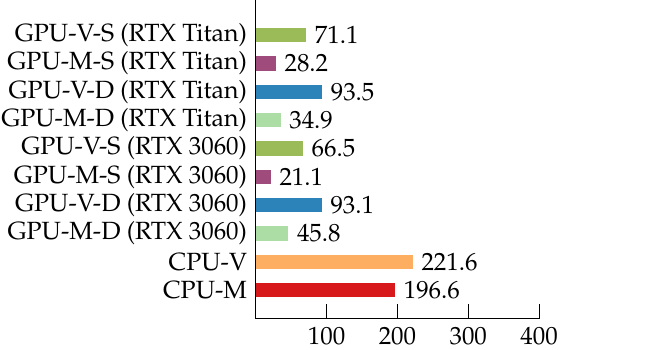
Figure 15. Comparison between the execution times ( × 10) obtained for the parabolic propagation at 5.00 Ghz.